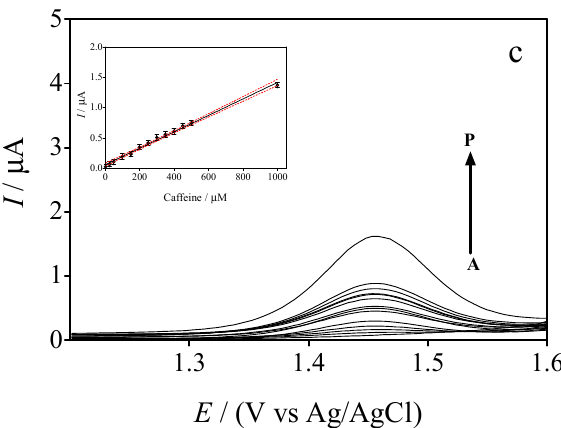
Figure 6. DPV curves for ( a ) Gr, ( b ) GrRAC and ( c ) GrRGC by adding standard caffeine solution (0.01 M) in 0.5 M H 2 SO 4 : (A) 2.5, (B) 25, (C) 50, (D) 100, (E) 150, (F) 200, (G) 250, (K) 300, (L) 350, (M) 400, (N) 450, (O) 500 and (P) 1000 µM. Insets: Plots of the electrochemical response, in terms of current, as a function of the caffeine concentration.